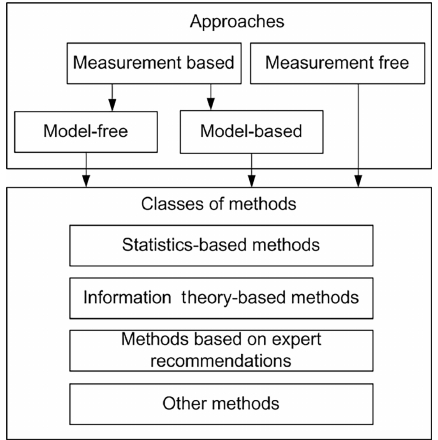
Figure 2. Proposed classification of methods for sensor network evaluation.